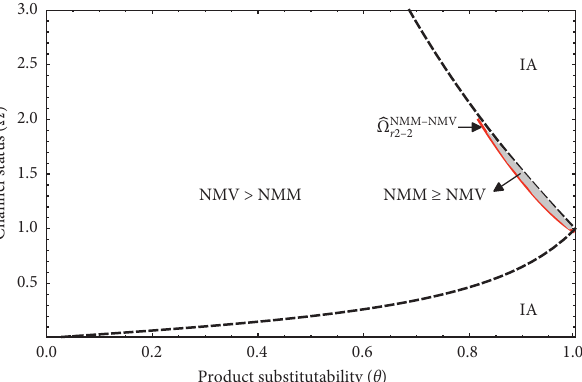
Figure 3: Comparison of retailer 2 profits under